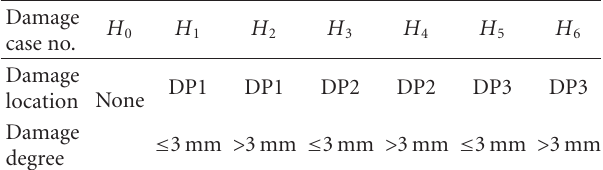
Table 2: Damage cases denoted according to damage location and degree.